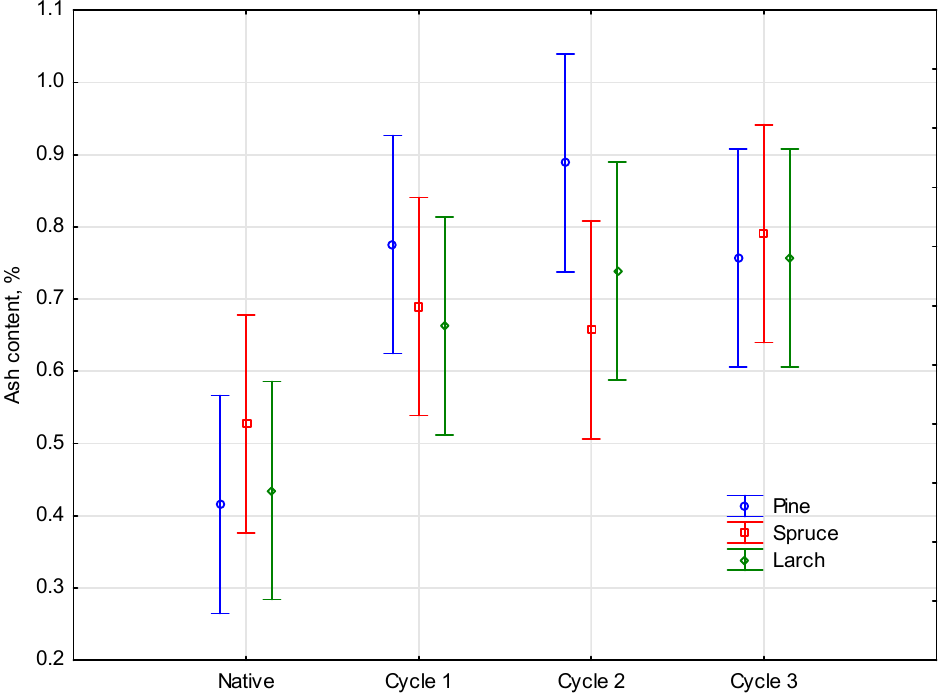
Figure 5. E ff ect of the number of salinated water soaking cycles on the ash content in respective wood species. wood